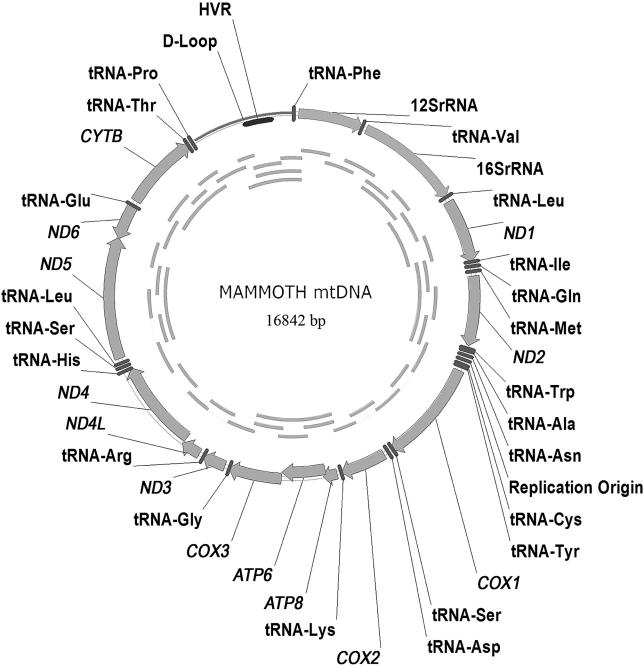
Mitochondrial Genome of the Woolly MammothM. primigenius
The complete mitochondrial genome was determined independently in two different laboratories using designs with multiple primers for overlapping PCR fragments ranged from ~325 to ~650 bp; the longer PCR fragments were also produced and sequenced. The overlapped PCR products used for sequencing and cloning are shown by the inner circle. Only PCR fragments produced from different pairs of primers are shown. Two genes,ATP6 andND4L, overlap with neighboring genes.